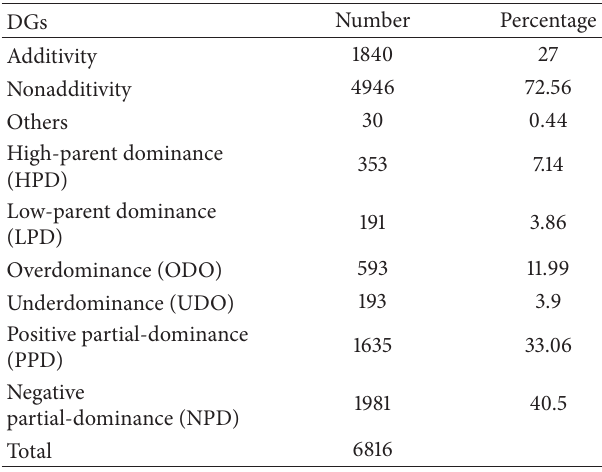
Table 1: Summary of dominance patterns of differentially expressed